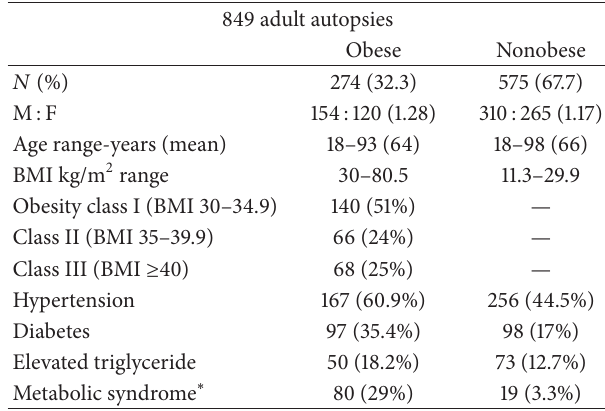
Table 1: Characteristics of the obese and nonobese patient popula- tions. 849 adult autopsies